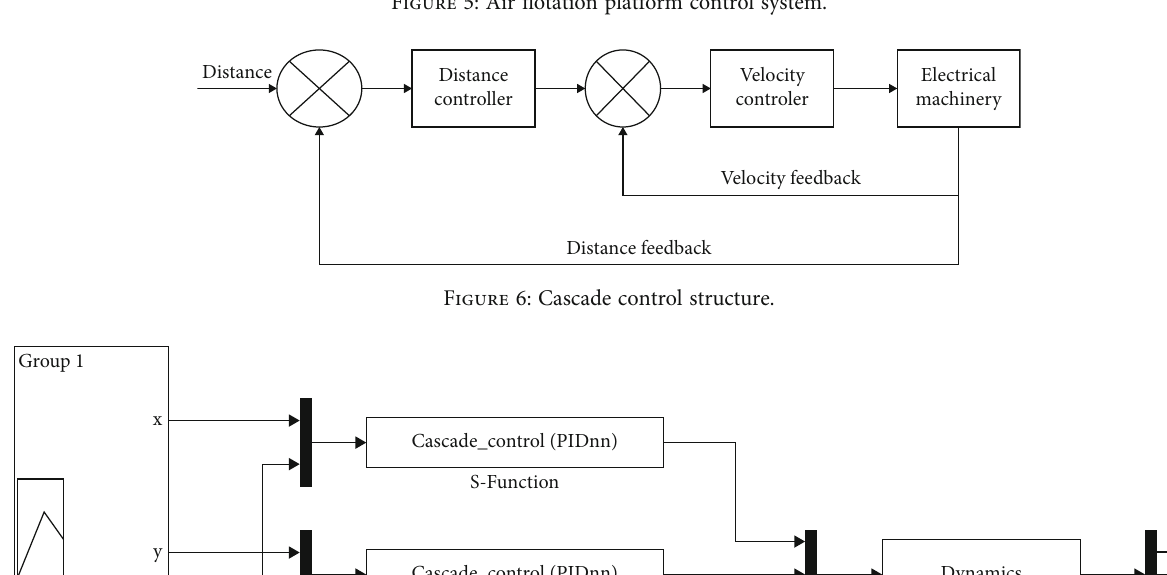
Figure 5: Air fl otation platform control system.